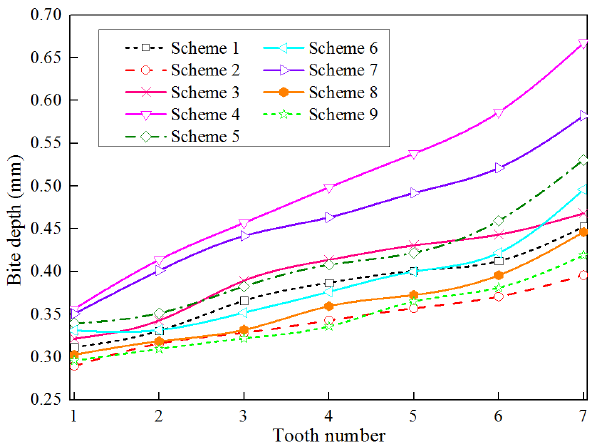
Figure 17. The bite depth of slip tooth in different schemes. Table 4. Orthogonal test result.